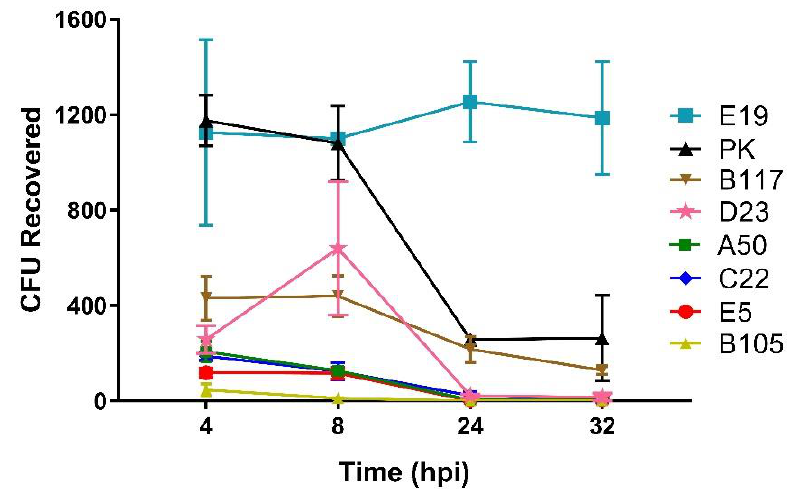
Figure 3. Time-course of intracellular survival of Group B Streptococcus (GBS) in Caco-2 cell monolayers. Differentiated Caco-2 cell monolayers were infected with GBS for 2 h at a multiplicity of infection of 10. After 2 h antibiotic treatment (4 h post infection, hpi), the infected cells were further incubated for an additional 8-, 24-, and 32-hpi. At each time point, the infected cells were lysed, and the number of intracellular bacteria were recovered. Isolates are labelled on the right. The data shown are the average number of intracellular bacteria in colony forming units (CFU) from three independent experiments with error bars representing standard error of measurement ( ± SEM). Assays were performed in duplicate.